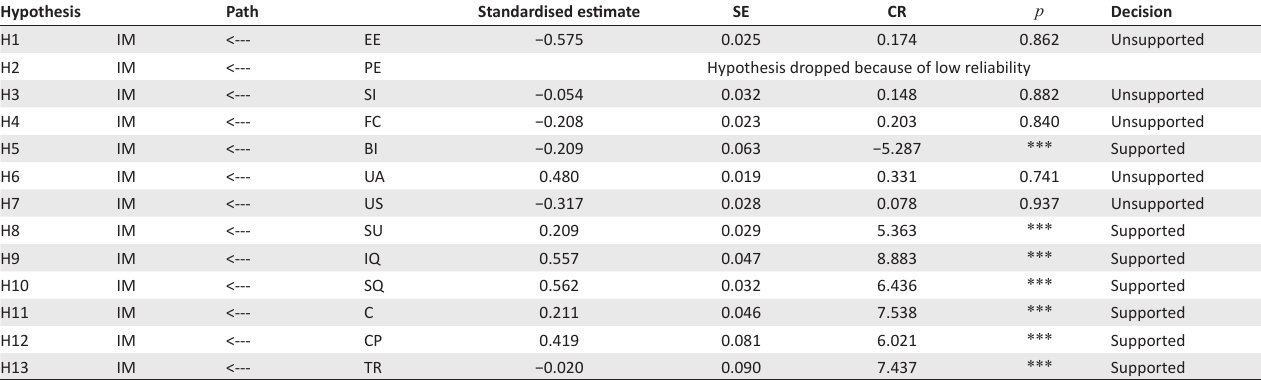
TABLE 2: The result of the tested hypothesis. Hypothesis